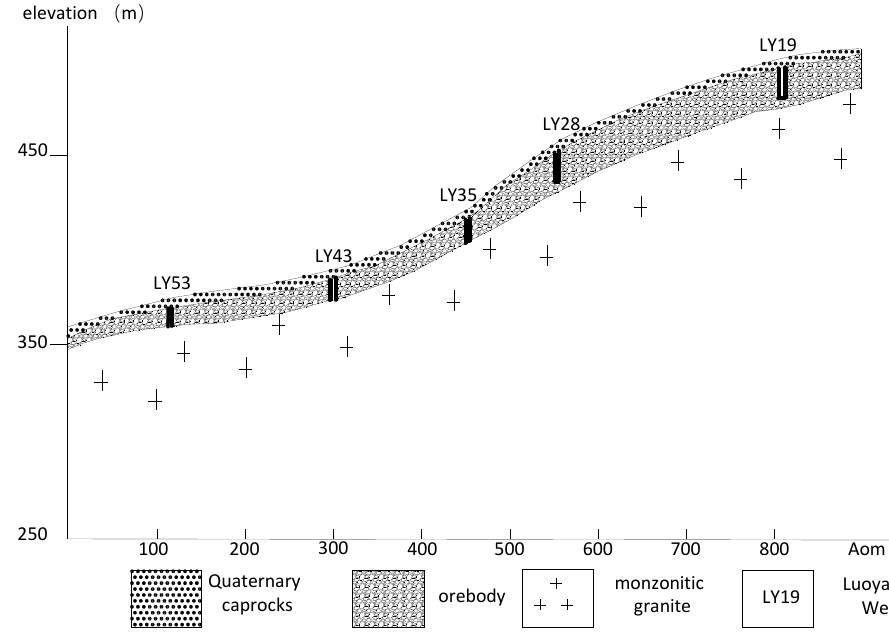
Figure 2. Longitudinal section of ore body thickness variation.